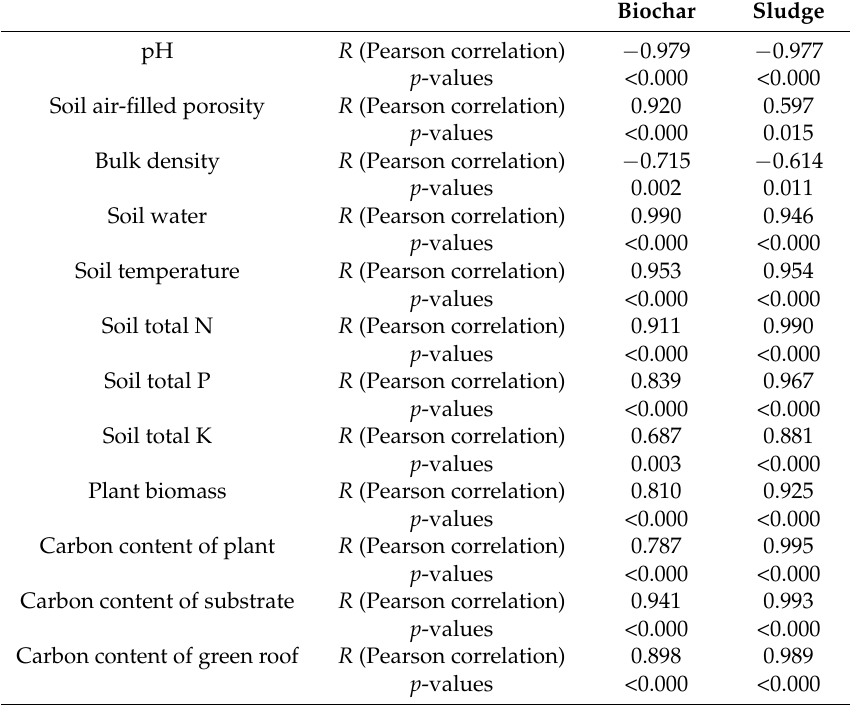
Table 2. Correlation between the additives and the properties of the roof substrate.